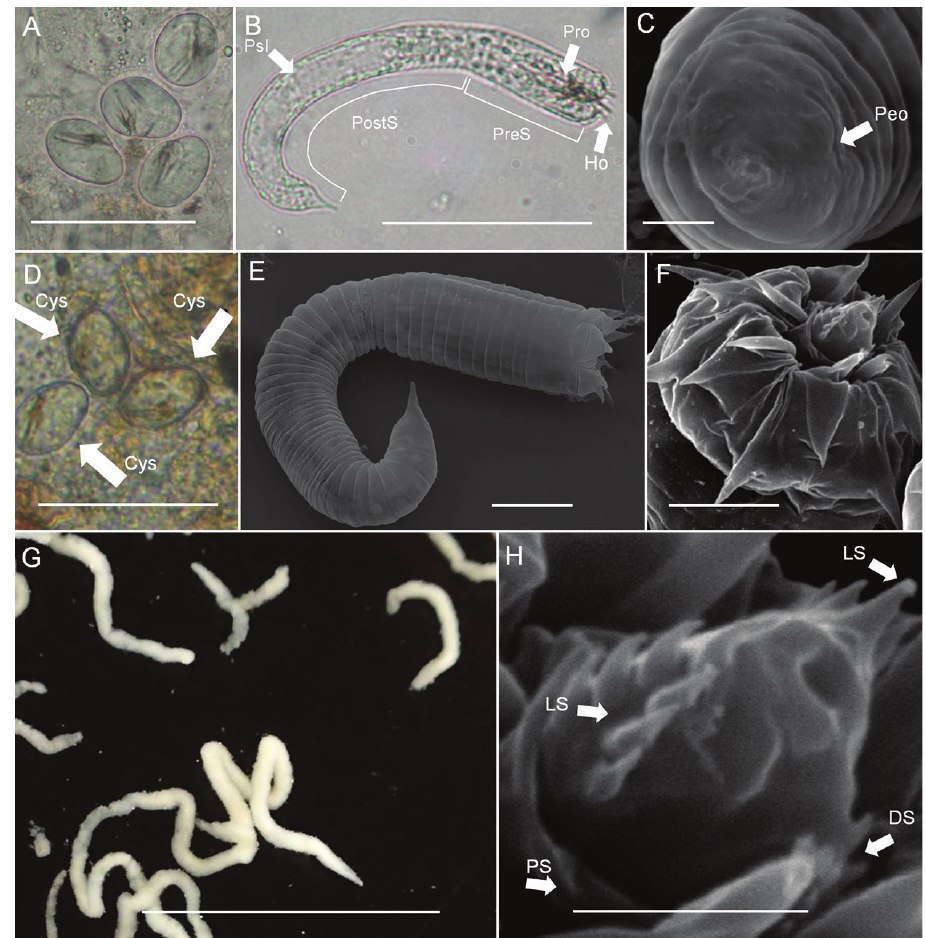
Figure 6. Immature stages of Acutogordius taiwanensis sp. n. A–B Live A cyst-form and B worm-form larvae in water C Posterior view of a worm-form larva D Cysts in an infected snail; E Worm-form larva under SEM F Anterior view of a larva showing the hook arrangement G Egg strings H Close-up of the proboscis. DS, dorsal spines; Ho, hooklet; LS, lateral spines; Peo, pseudointestine exterior opening; PostS, postseptum; PreS, preseptum; Pro, proboscis; PS, proboscis sheath; PsI, pseudointestine gland. Scale bars 50 µm ( A–B ), 2 µm ( C ), 50 µm ( D ), 10 µm ( E ), 5 µm ( F ), 1 cm ( G ), and 2 µm ( H